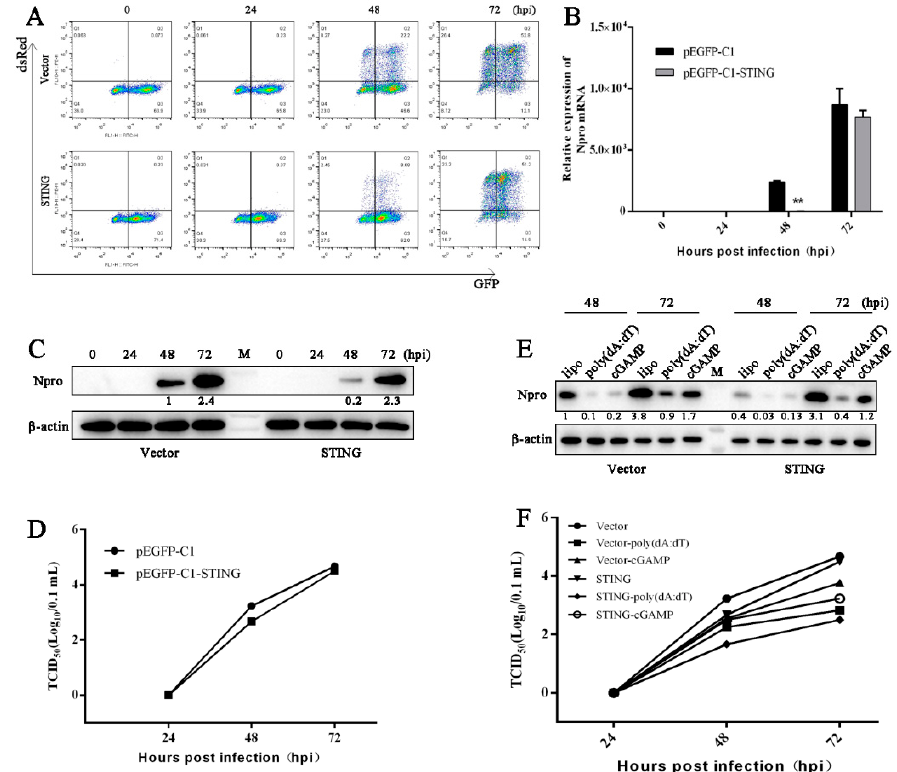
Figure 2. The replication of PRRSV in porcine STING stable Marc-145 cells with or without stimulations. ( A – D ) The STING or vector control stable Marc-145 cells seeded in 24-well plates were infected with rXJ17-5-dsRed at a MOI of 0.1, for 0, 24, 48, 72 h, and then assayed by flow cytometry ( A ), RT-qPCR ( B ), Western blotting ( C ) and TCID50 ( D ). The dsRed/GFP double signal represents that those Marc-145 cells stably expressing STING or control GFP were infected by rXJ17-5-dsRed. ( E-F ) Marc-145 cells stably expressing STING or control GFP grown in 24-well plates were stimulated by transfection of poly (dA:dT) (1 μ g/mL) or 2 ′ 3 ′ -cGAMP (1 μ g/mL) for 24 h using transfection reagent lipofectamine 2000 (lipo). Then, the cells were infected with PRRSV at a MOI of 0.1, for 24, 48, and 72 hpi, respectively. The infected cells were assayed by Western blotting ( E ) and TCID50 ( F ). ** p < 0.01 versus the vector pEGFP-C1 control groups.